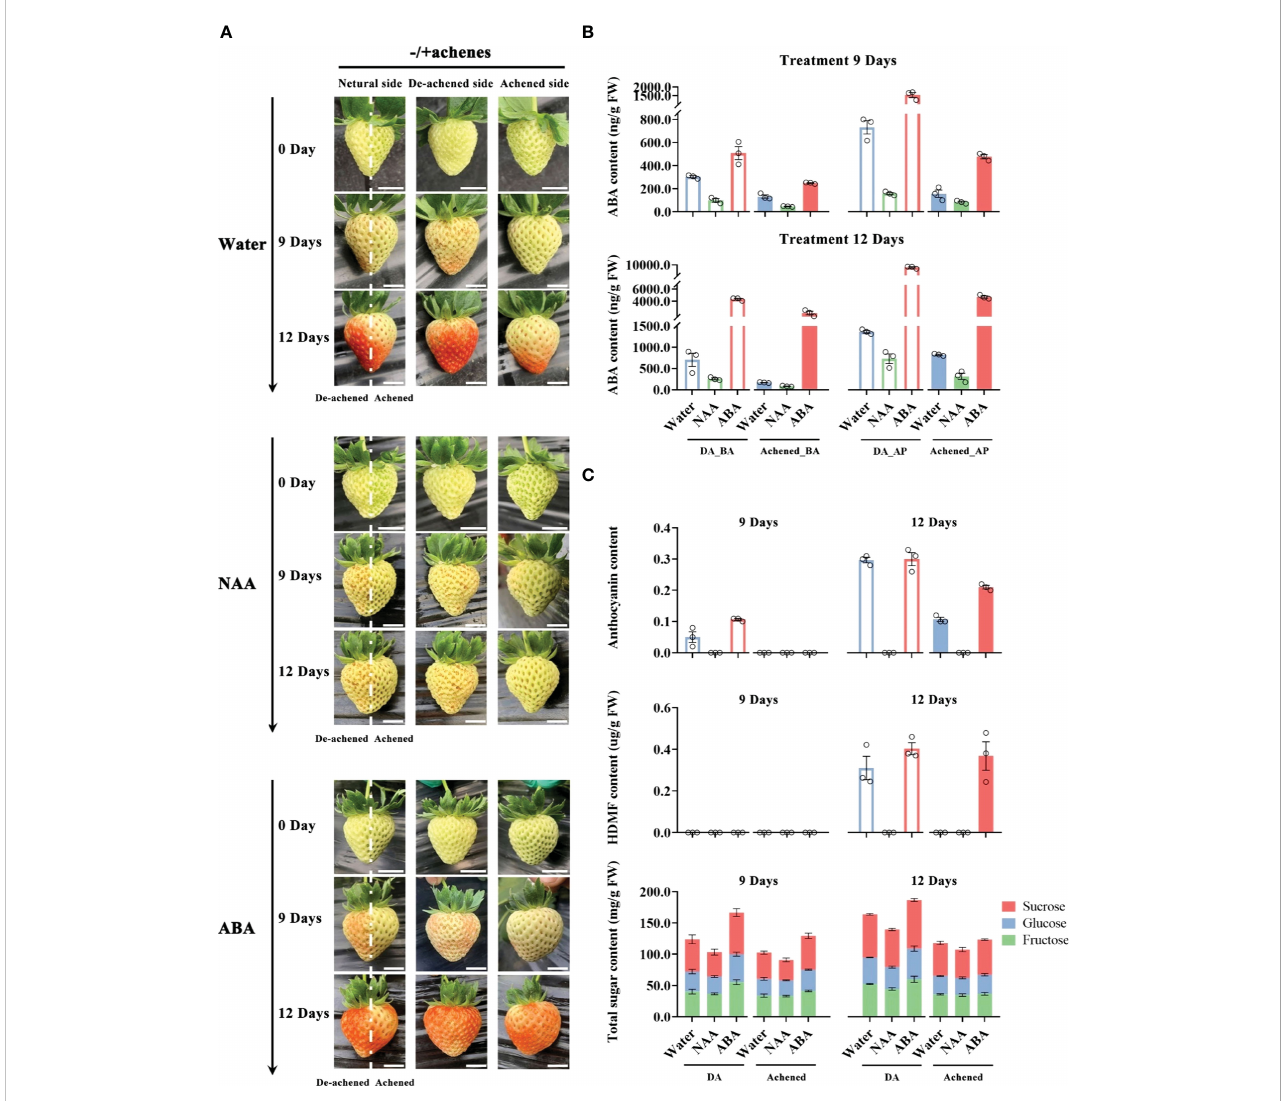
FIGURE 1 Levels of ABA, HDMF, sugars, and anthocyanins the receptacle after removing and exogenous hormone treatments. (A) Whole receptacle from which half the achenes were removed along the central axis at the G stage were injected with water, ABA (500 m M), or naphthylacetic acid (NAA, 500 m M), and photographed after 0, 9 and 12 days. Photographs are shown of individual fruit from three perspectives: ‘ neutral side ’ , with the achenes removed from the left side of the dotted lines ( ‘ De-achened side ’ ), or from the perspectives of the left or right sides of the dotted lines ( ‘ Achened side ’ ), as indicated. Scale bars = 1 cm. (B) ABA levels in the different parts of the receptacles at 6 and 9 days after the treatments. The DA, Achened, BA, and AP in labels represent the de-achened and achened sides, basal and apical parts of receptacles, respectively. (C) Levels of ripening-related compounds in the DA and achened sides of the receptacles at 6 and 9 days after the exogenous hormone treatments. DA and Achened indicate the de-achened and achened sides of the receptacles, respectively. The data values are the mean ± SD of three biological